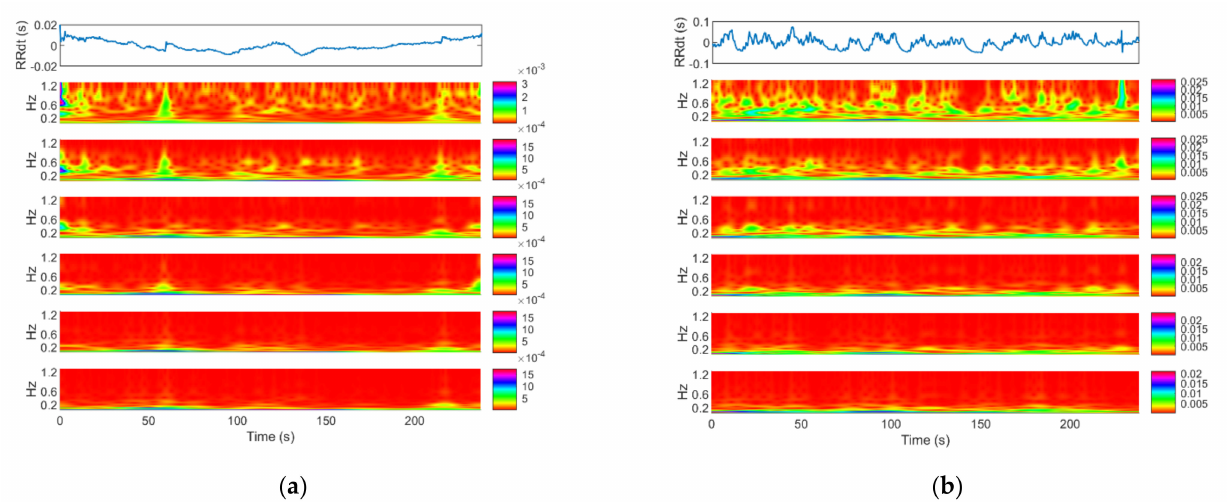
Figure 8. The multiscale wavelet power spectra of two 4-min length windows at different scales obtained by the coarse- grained scale (mean operator). ( a ): with seizure; ( b ): seizure-free. The first plot on the top, both for ( a , b ), is the original time series to which the coarse-grained scale was applied. Below, the wavelet power spectra from scale one to six are shown. The time-frequency representations were obtained by continuous wavelet transform. Frequency range: